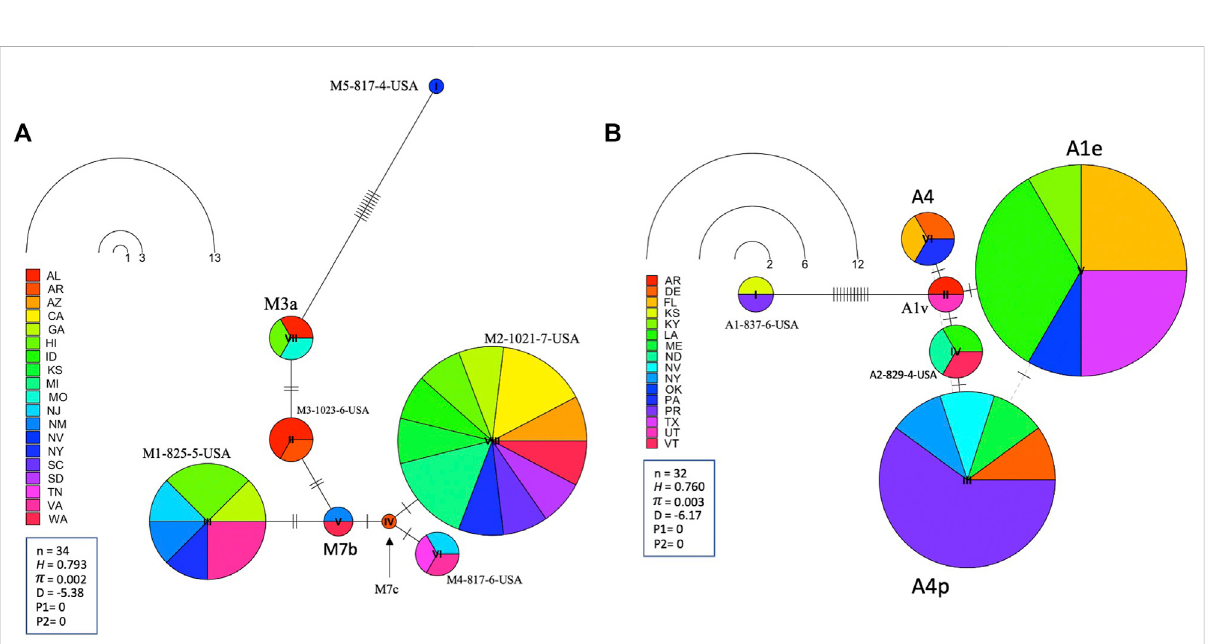
FIGURE 7 State-by-State representation of the COI-COII haplotype network of both M and A lineages; (A) and (B) respectively. Number of samples (n), haplotype diversity ( H ), nucleotide diversity ( π ), Tajima ’ s statistic ( D ), Tajima ’ s p -values under normal (P 1 ) and beta (P 2 ) distributions. Circle size is relative to the number of haplotype copies present in the dataset. Perpendicular lines on branches represent nucleotide